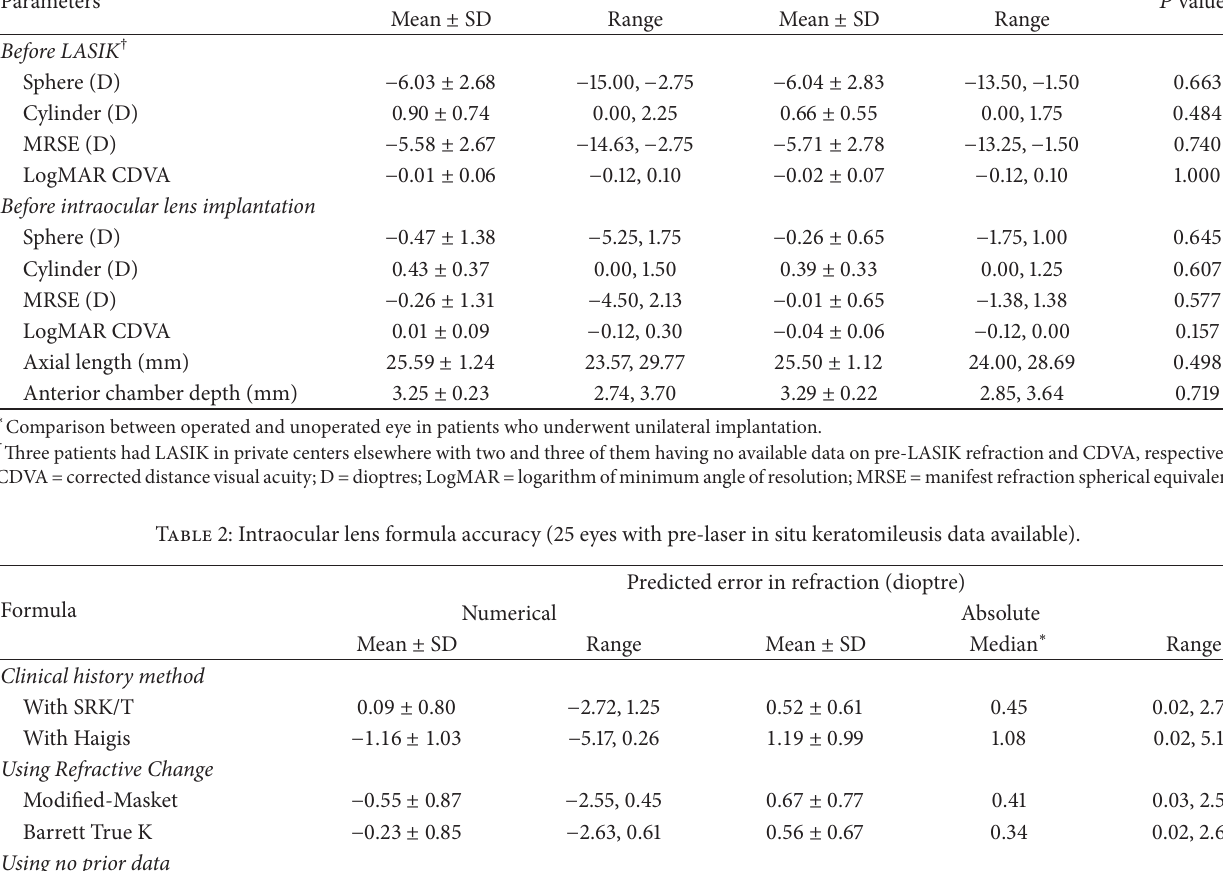
Table 1: Baseline characteristics before laser in situ keratomileusis (LASIK) and before intraocular lens implantation. Parameters